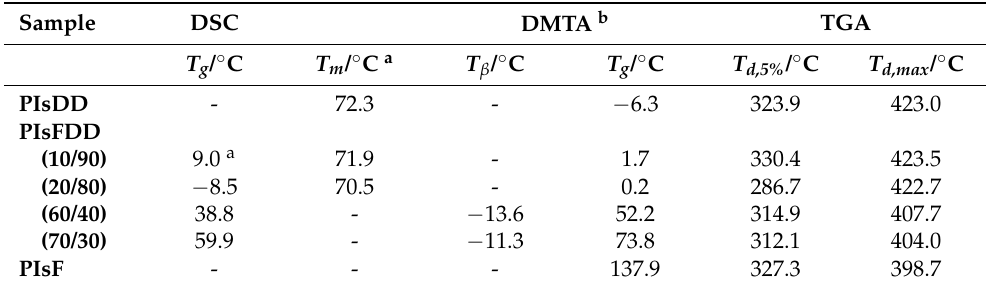
Figure 3. DSC heating traces of selected PIsFDD (co)polyesters. Table 2. Thermal properties of PIsFDD (co)polyesters with different